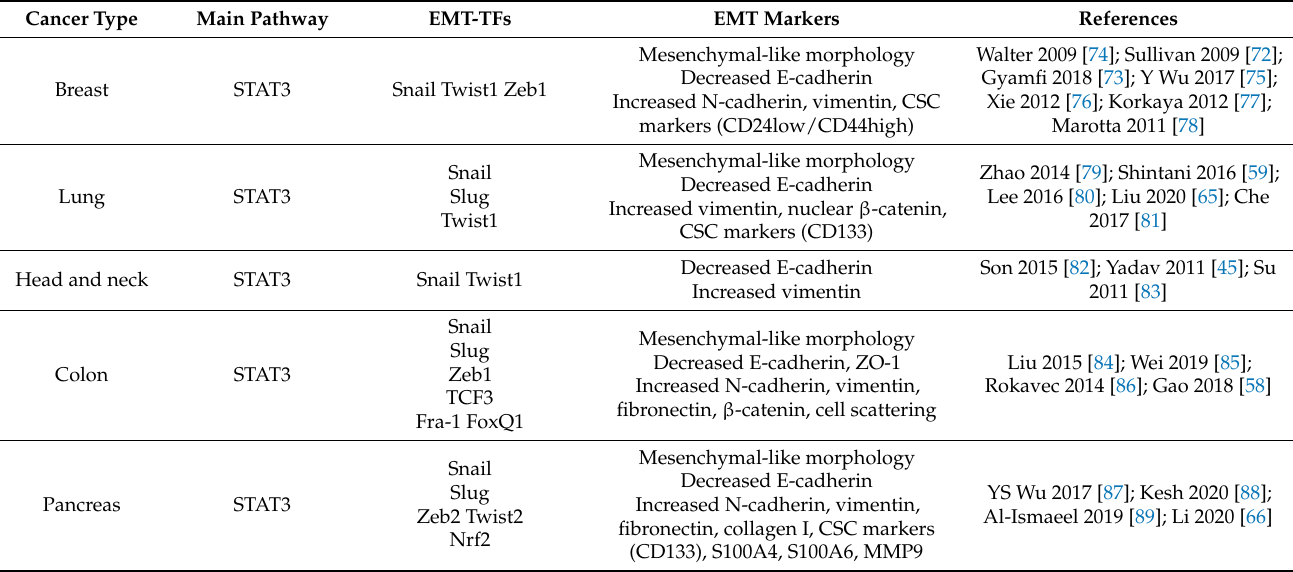
Table 1. Experimental evidence of the implication of interleukin 6 (IL-6) on epithelial–mesenchymal plasticity (EMP) in